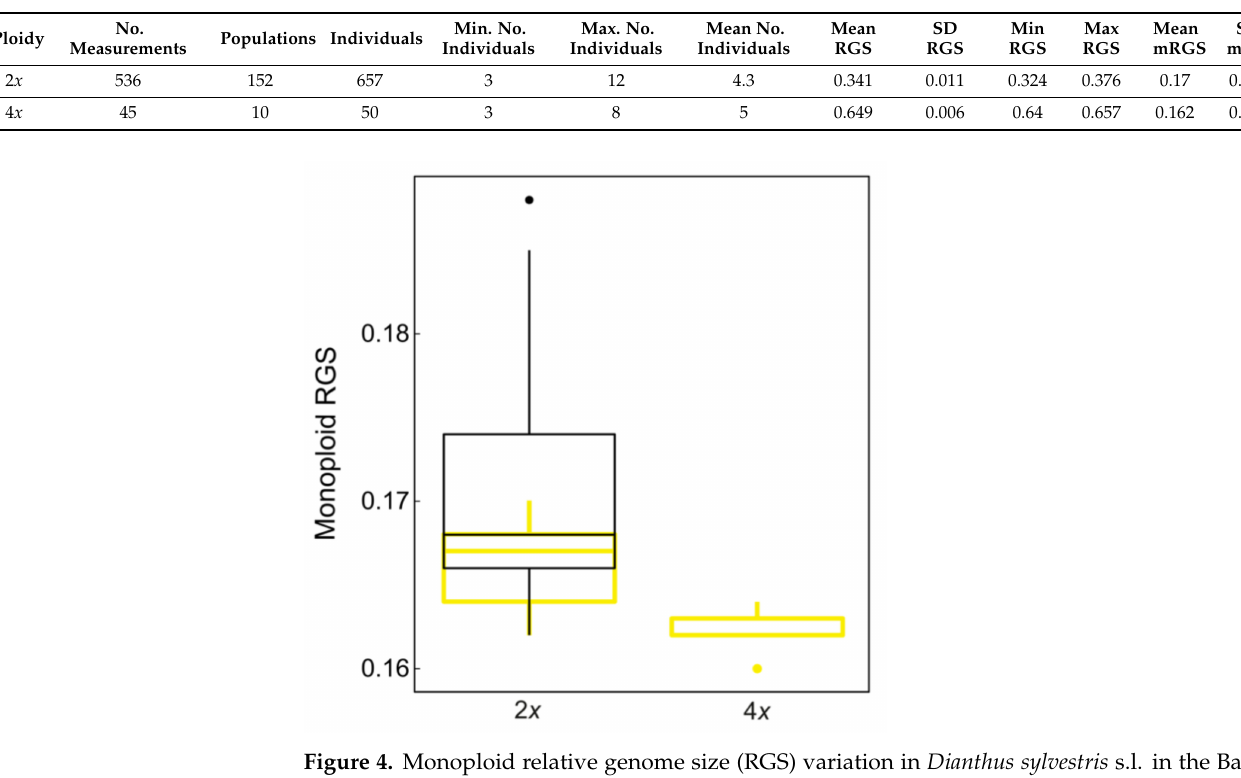
Table 1. Descriptive statistics of relative genome size (RGS) variation in diploid (2 x ) and tetraploid (4 x ) populations of Dianthus sylvestris s.l., for which at least three individuals were analyzed. SD, standard deviation; mRGS, monoploid RGS.